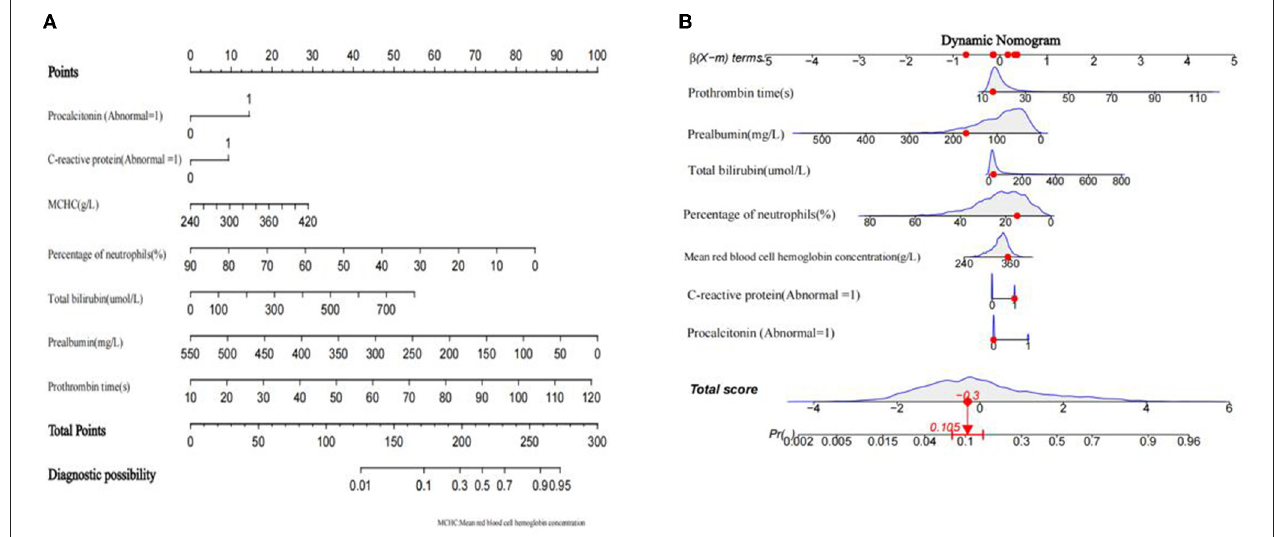
FIGURE 2 | Developed a nomogram of decompensated cirrhosis combined spontaneous bacterial peritonitis model. (A) spontaneous bacterial peritonitis nomogram for patients with decompensated cirrhosis was developed in the traindata, with prothrombin time, prealbumin, total bilirubin, lymphocyte ratio, mean red blood cell hemoglobin concentration, procalcitonin level and C-reactive protein level incorporated. (B) An example of nomogram.